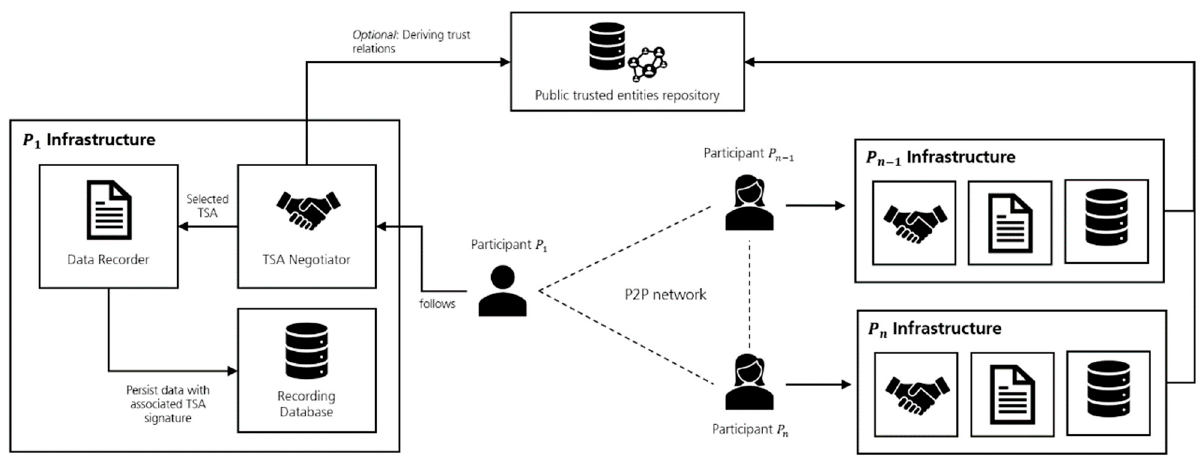
Figure 3. Approach for Decentralized Documentation of Maritime Traffic Incidents.